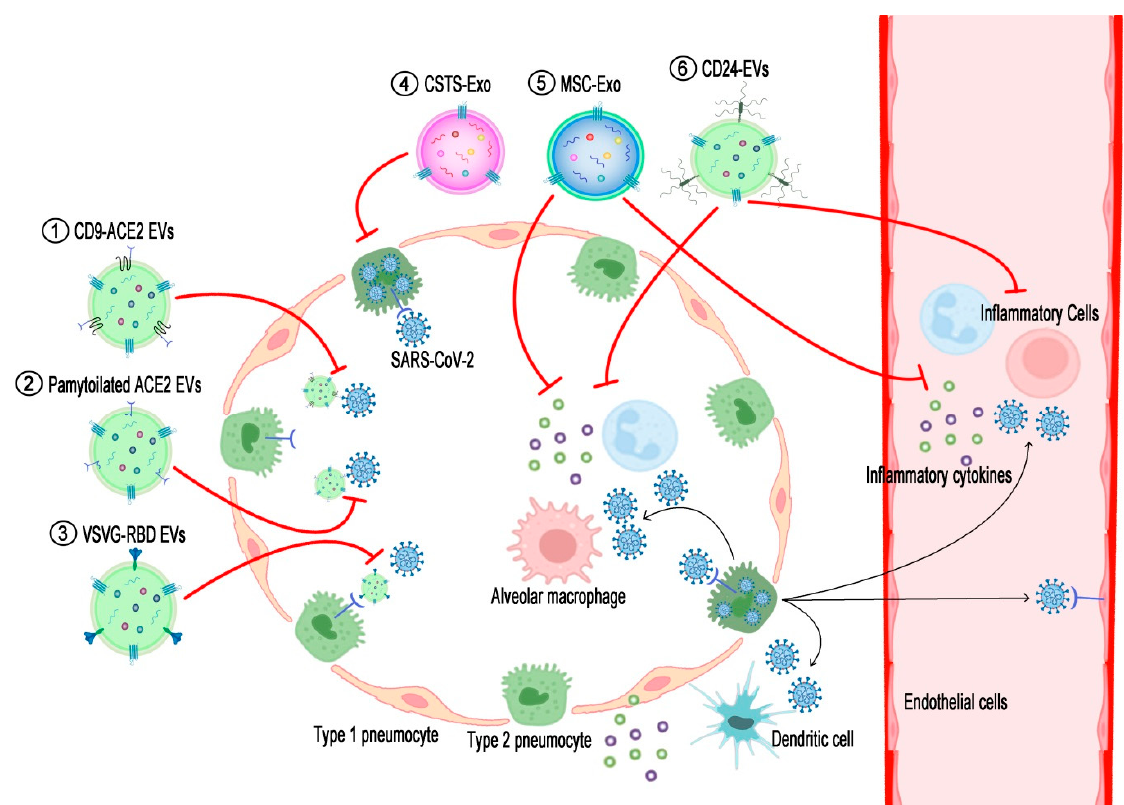
Figure 1. Schematic diagram displaying action mechanisms of EV-based therapeutics against COVID-19. SARS-CoV-2 enters and proliferates in the type 2 pneumocytes of the lung and then spreads into the interstitial tissue and bloodstream. Components of either viruses or dying cells activate alveolar macrophages and dendritic cells to recruit inflammatory cells to the lung tissue, resulting in the over-secretion of pro-inflammatory cytokines (cytokine storm). (1) EVs expressing ACE2-fused with CD9 (CD9-ACE2 EVs) or (2) palmitoylated ACE2 (palmitoylated ACE2 EVs) prohibit the binding of viruses to cellular ACE2. (3) EV-expressing RBDs of SARS-CoV-2 spike proteins fused with the stem region of the VSVG protein (VSVG-RBD EVs) target ACE2-expressing cells and thereby introduce anti-viral siRNAs to inhibit the proliferation of the viruses. (4) COVID-19-specific T-cell-derived exosomes (CSTS-Exo) show anti-viral effects on virus-infected cells by their cargo such as IFN γ . (5) EVs from mesenchymal stem cells (MSC-Exo) or (6) EVs expressing CD24 (CD24-EVs) can ameliorate the cytokine storm induced by over-activated inflammatory cells in the severe phase of COVID-19. The black lines briefly indicate the pathogenic pathways of SARS-CoV-2 infection in the airway, and the red lines denote the action mechanisms of the EV-based therapeutics interrupting the COVID-19 pathogenesis.